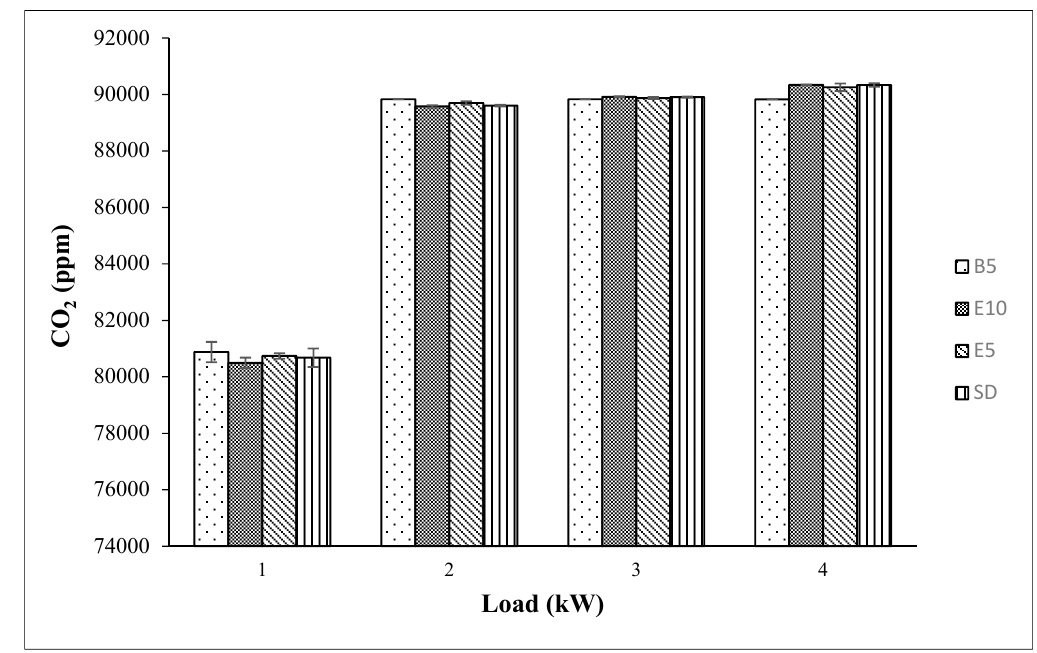
Figure 20. Concentration of CO 2 for B5, E10, E5, and SD under different load conditions.